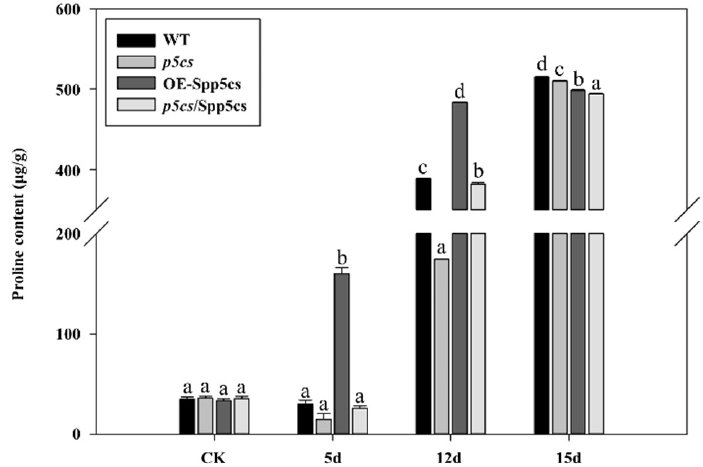
Figure 6. Proline contents of WT, OE-SpP5CS, p5cs/SpP5CS -complemented and p5cs mutant plants after the soil drought treatment. The soil drought treatment adopts continuous withholding water. CK is the control group under the condition of normal irrigation. The experiment has three biological and technical replicates. Data are the mean values ± SD obtained from three independent experiments (error bars = SD, n = 15). Different letters indicate significant differences in the proline content (one-way ANOVA, Tukey’s test, p < 0.05).